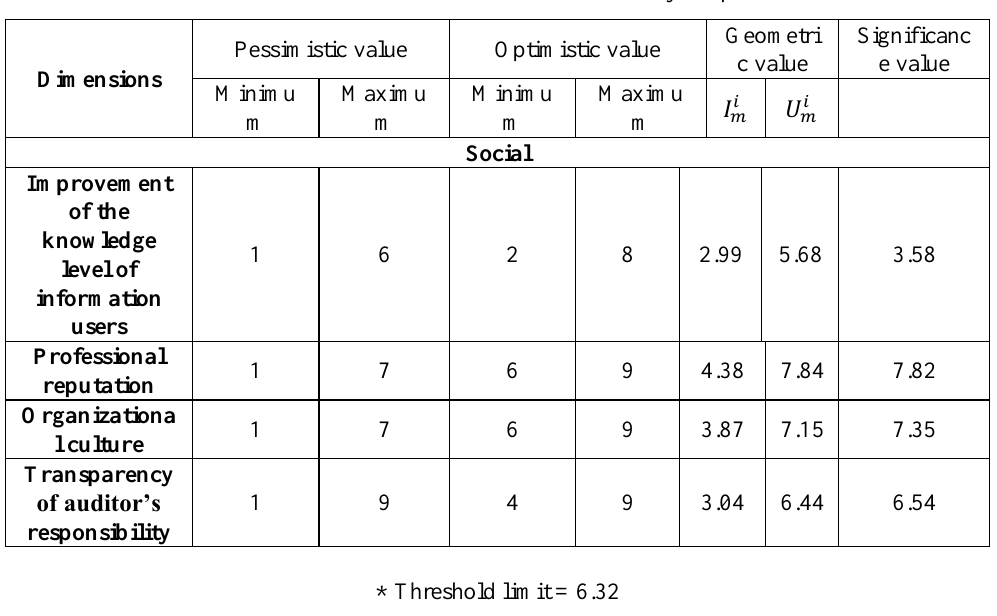
Table 7. Performance indicators based on the Fuzzy Delphi